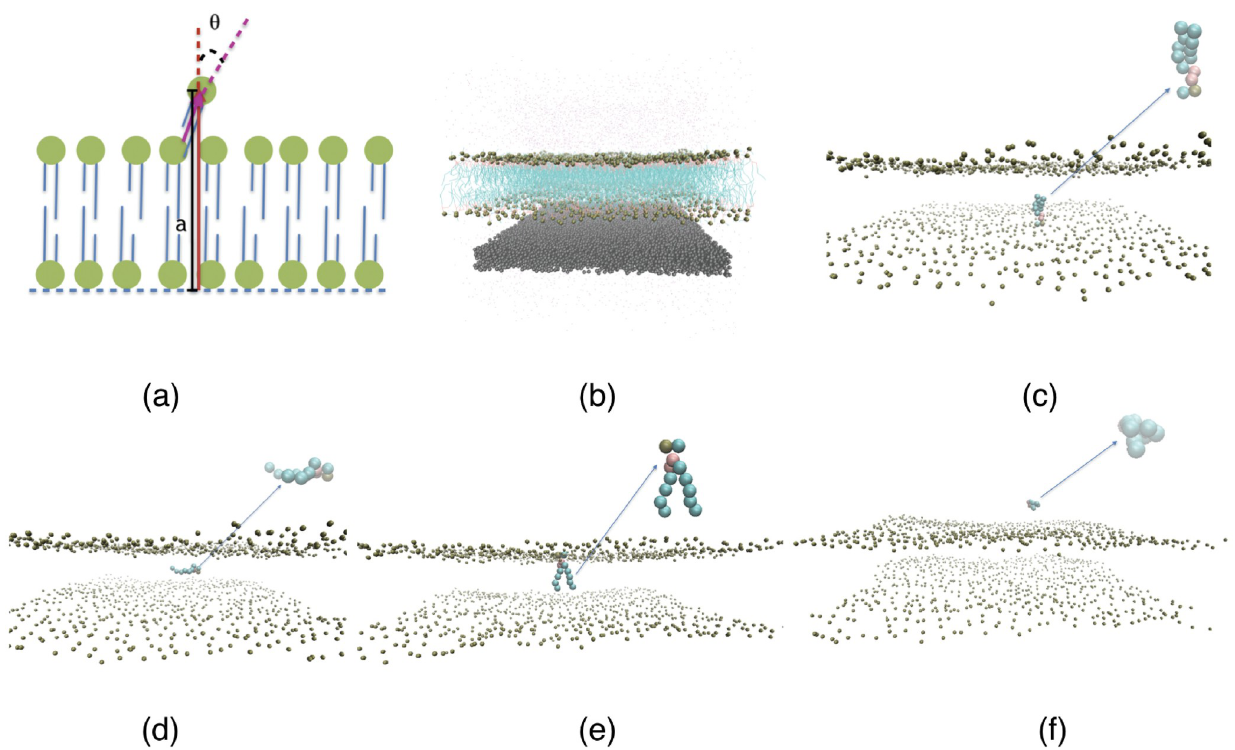
Fig 2. (a) The schematic depiction of the geometry of the PSSLBL (system C). (b) MD simulation snapshot of the PSSLBL; only 1/10 th of the total number of water molecules are displayed for a clearer view. (c-f) Snapshots representing the positions (and configurations) of a single lipid molecule (zoomed in the inset showing the corresponding lipid configuration) corresponding to its different locations inside and outside the LBL of the PSSLBL. These different locations are (c) inner leaflet, a = 0 Å ; (d) hydrophobic core, a = 22 Å ; (e) outer leaflet, a = 44 Å ; (f) bulk water, a = 70 Å . For all the cases we use the following color codes: purple for water; dark green for the planar support; light green for the hydrophobic tails of lipids; Bronze for the hydrophilic head of the lipids. For figures (c-f), only the hydrophilic heads of the lipid molecules of the LBL are displayed for a clearer view.